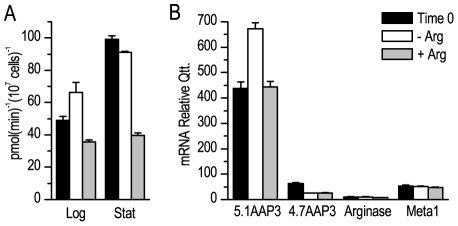
Amino acid starvation regulates the arginine transporter rate and 5.1 kb AAP3 mRNA level in L. (L.) amazonensis.A. Arginine uptake of mid-log and stationary phase L. (L.) amazonensis in non-starved parasites (black), 4-h starved parasites (white) and 4-h starved + 400 µM arginine parasites (gray). B. Total RNA of non-starved parasites (black), 4-h starved parasites (white) and 4-h starved + 400 µM arginine parasites (gray). RNA was used to prepare the cDNA, as described in Material and Methods. Equal amounts of cDNA were then used in qRT-PCR to determine the copy-number of both copies of the arginine transporter, arginase and Meta1. All determinations were normalized by GAPDH. Results of a representative experiment. Data are shown as the mean±S.E. (n = 3).